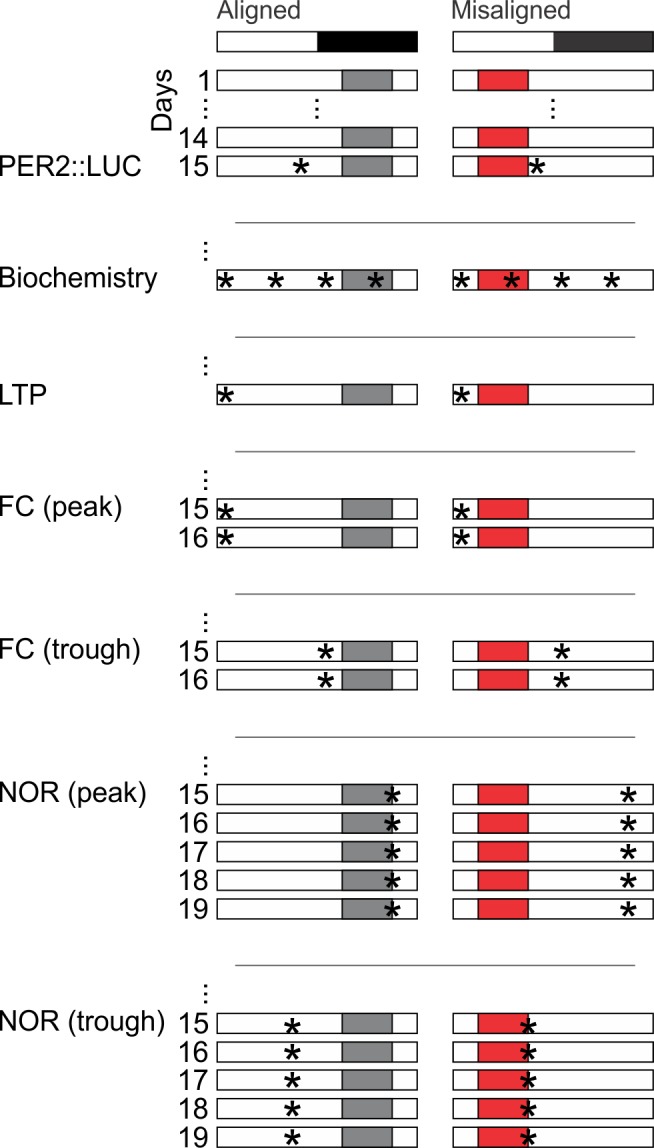
Cartoon schematic of experimental design.Standard mouse cages were modified to restrict access to the food chamber. Access was controlled by a motorized gate controlled by timed relay switches. Mice could only access food pellets when the gate was lifted (6 hr), and positive drive of the motor kept the gate closed for the remaining 18 hr. The scheduled feeding protocol was maintained for a minimum of 2 weeks prior to and during sample collections and behavioural tests, indicated by *. PER2::LUC, PER2-driven bioluminescence. LTP, long term potentiation. FC, fear conditioning. NOR, novel object recognition.